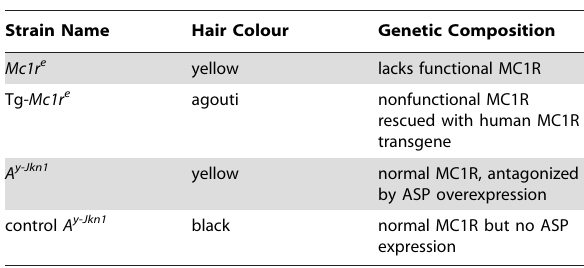
Table 2. Experimental